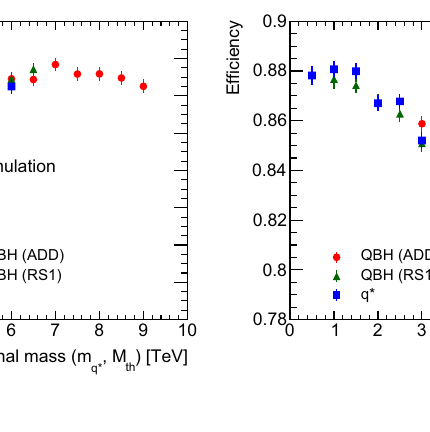
definition is detailed in Table 2. The description of the selection criteria can be found in the